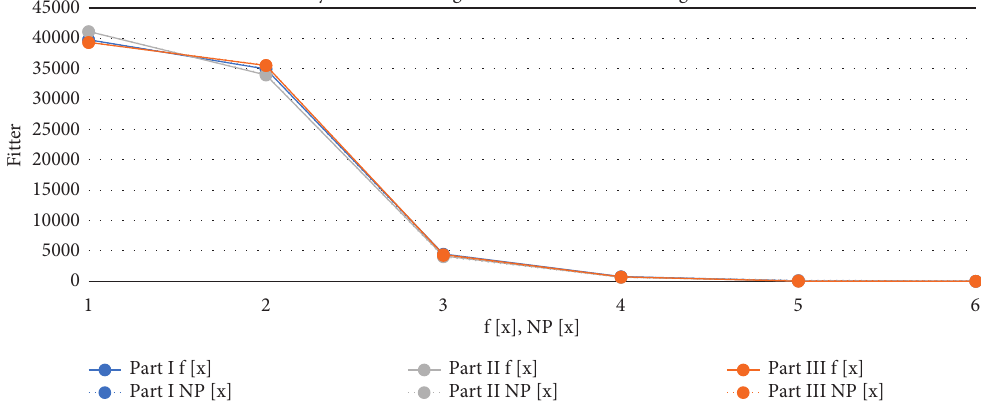
Figure 3: Fitting extended logarithmic to dynamic word-length distribution data of the three parts of DRC. Table 7: Word-length distribution of the sample texts from